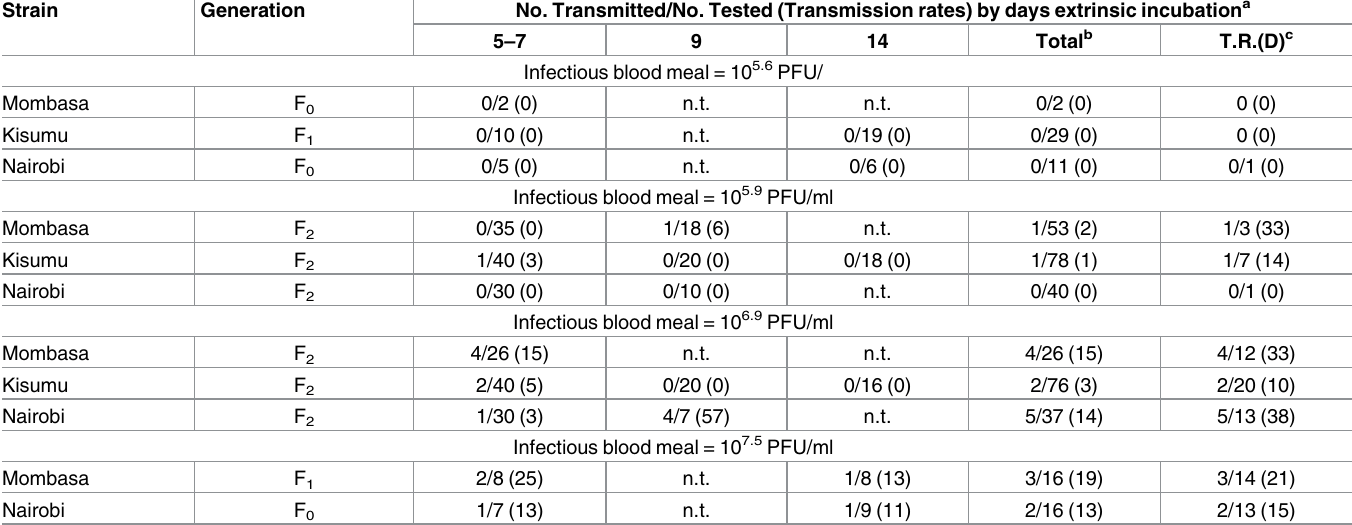
Table 4. Transmission rates by day after feeding on a chikungunya virus blood meal.